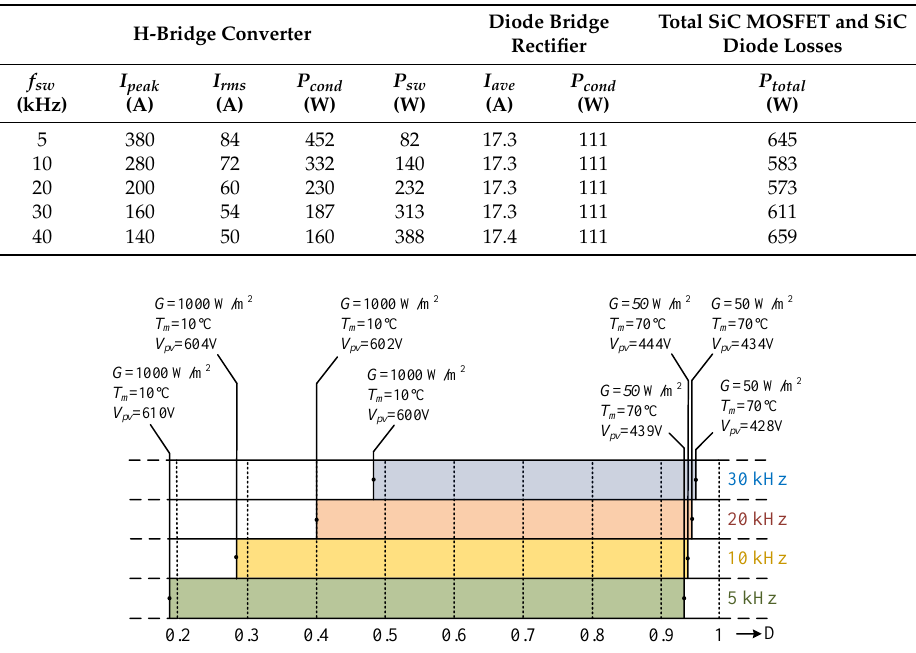
Figure 16. The variations in duty ratio, D of the H-bridge circuit in MPPT converter over the entire operating range for f sw = 5, 10, 20, and 30 kHz, V dc = 700 V, and n = N s / N p = 1.52.